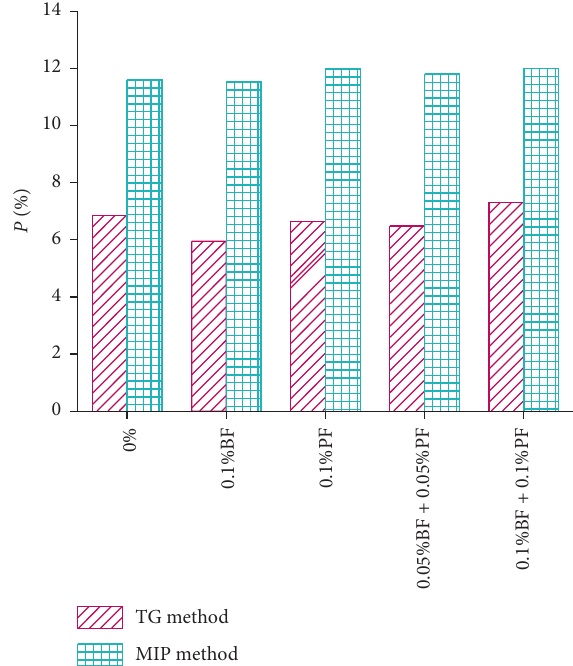
Figure 14: Comparison of pore volume of BPFRC [43].